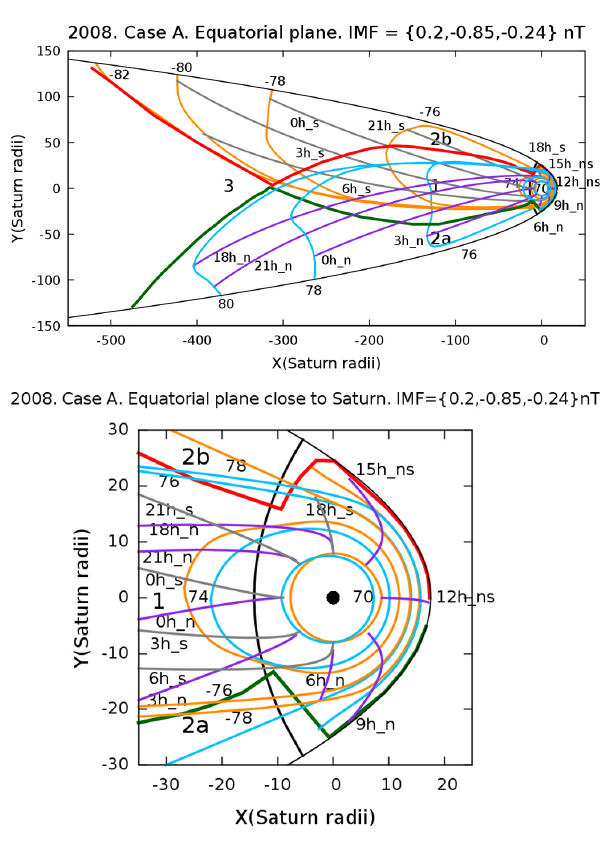
Fig. 2. As in Fig. 1 but for IMF vector (0.20, 0.85, − 0.24)nT. cap, and “3” to interplanetary lines that thread the tail. The blue and orange curves then show the mapping of constant latitude circles from the northern and southern polar iono- spheres, respectively, from ± 70 ◦ to ± 82 ◦ , at steps of 2 ◦ . For ± 70 ◦ to ± 74 ◦ the curves for the two hemispheres almost co- incide, while for ± 76 ◦ and above they are significantly dif- ferent from each other. The lines starting from + 82 ◦ do not intersect the equatorial plane at all, while the lines from − 82 ◦ in the MLT range from ∼ 8 to 11 h do pass through the equa- torial plane as shown. Similarly, the purple and grey lines show mappings of lines of constant MLT from the Northern and Southern Hemispheres, respectively, at steps of 3 h. A separatrix field line connecting the northern and south- ern magnetic nulls intersects the equatorial plane where the green and red curves meet. A potential drop equal to the po- tential drop between the two magnetic nulls is applied to the “ends” of the separatrices. So, along a separatrix strong field- aligned currents flow. For the case studied, at the southern polar cap these currents are associated with the dawn, while at the northern polar cap with the